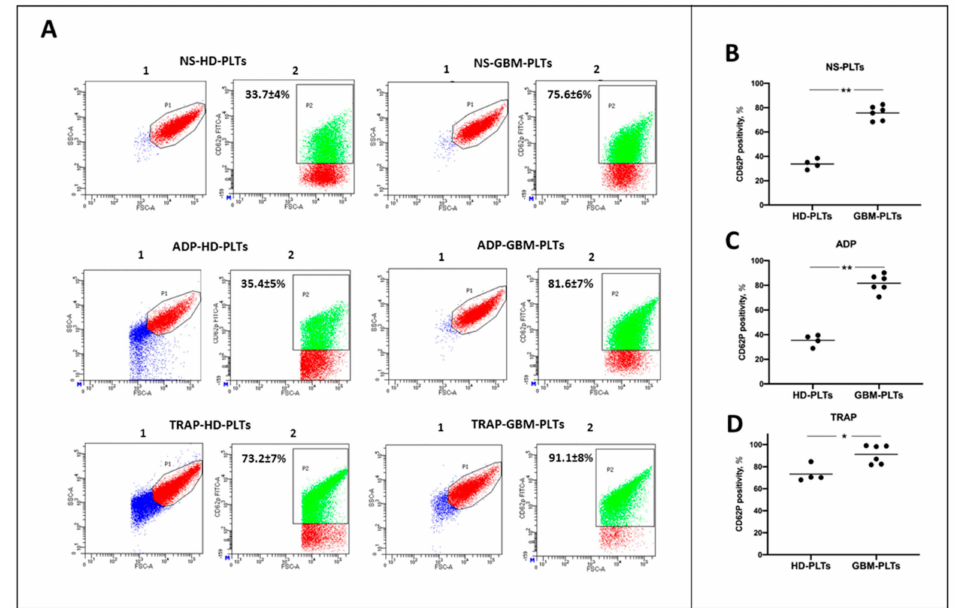
Figure 1. Glioblastoma platelets (GBM-PLTs) show a higher activated state compared to healthy donor (HD)-PLTs. ( A ) Representative dot plots from flow cytometry acquisition performed on HD- and GBM-PLTs under basal conditions and after stimulation with 10 µ M adenosine triphosphate (ADP) and 5 µ M thrombin receptor activated peptide (TRAP). NS: not stimulated. Plot 1 represents the first analysis performed according to side-scatter (SSC-A) and forward-scatter (FSC-A); blue cells